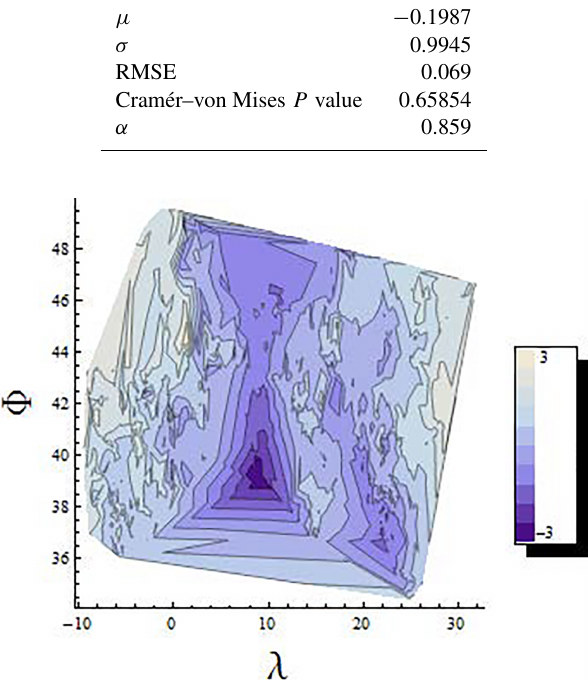
Figure 4. Latitude difference plot for each location set. The axes are contemporary latitude and